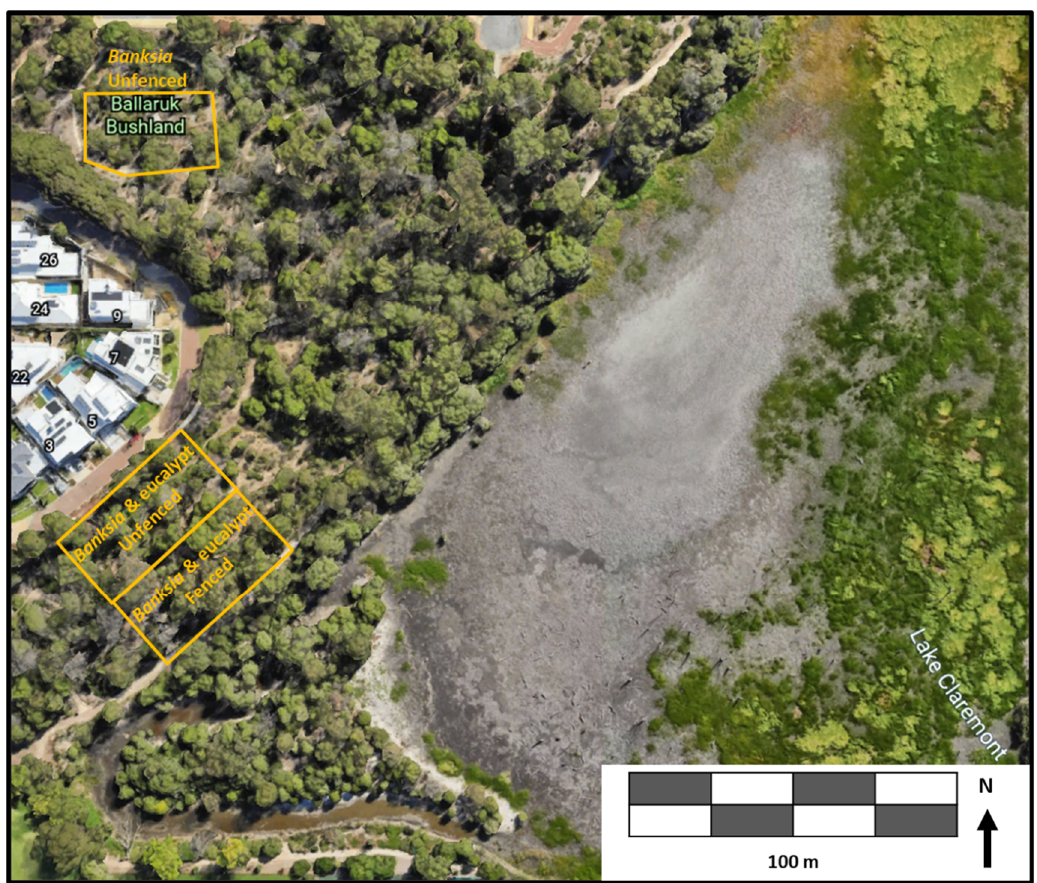
Figure A4. Locale of the transects for sampling understory structure adjacent to the fenced and unfenced recreational trails at Lake Claremont (source: Google Earth [90]).